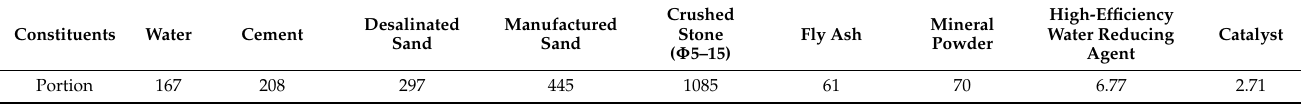
Table 3. Specific mix ratio design for concrete